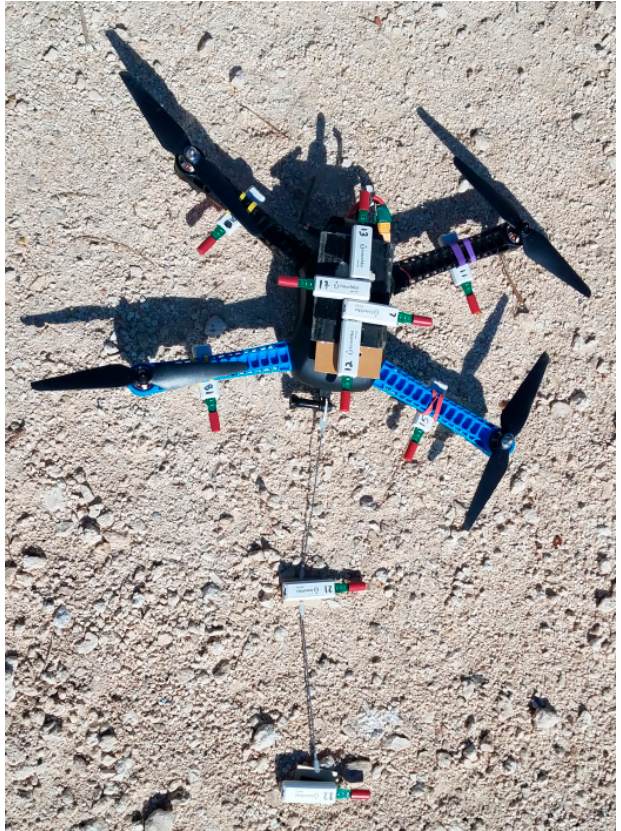
Figure 1. Photo of the Iris+ quad-copter with all 10 iMET-XQ sensors.